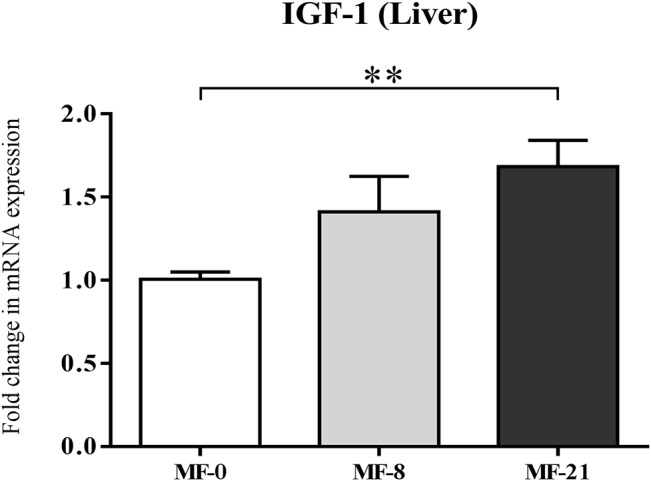
Effect of C8:0 in the MF groups on liver IGF-1 expression.IGF-1 mRNA level (in fold change). K-W test, P = 0.009, Dunn’s post tests, *P<0.05. Results are expressed as mean ± SEM.